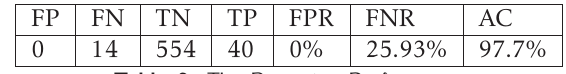
Table 6. The Detection Performance